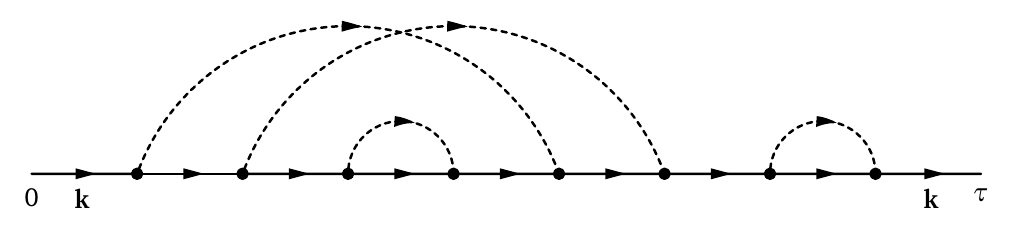
Figure 5: Bare expansion of the full Green function G ( k , τ ) for the Fröhlich polaron. A non- interacting Green function is denoted by a thin full ‘backbone’-line, a phonon propagator by a dashed arc and a vertex by a dot. The expansion order n is given by counting the number of arcs (here, n = 4). Only connected diagrams are considered. This diagram is a